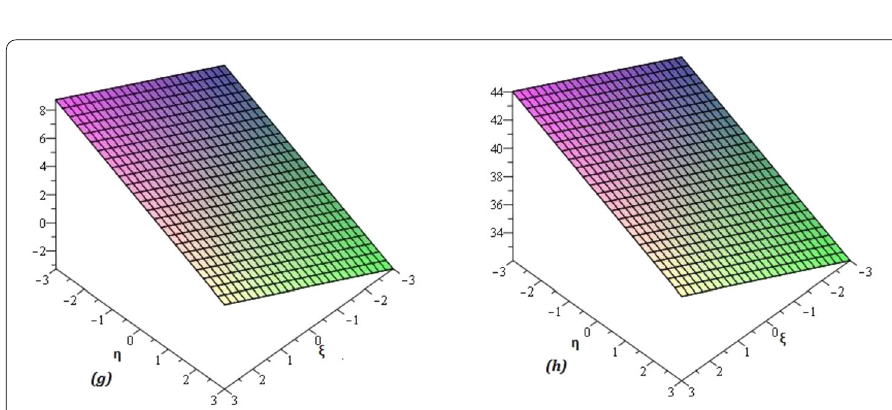
Figure 4 The plot of v solution of Example 1 at ( g ) β = 0.75 and ( h ) 0.50